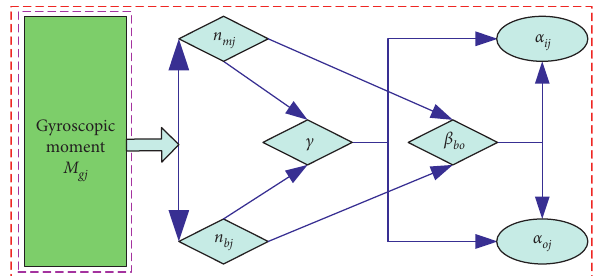
Figure 5: Analysis of variable transfer relationship of gyro moment M gj .